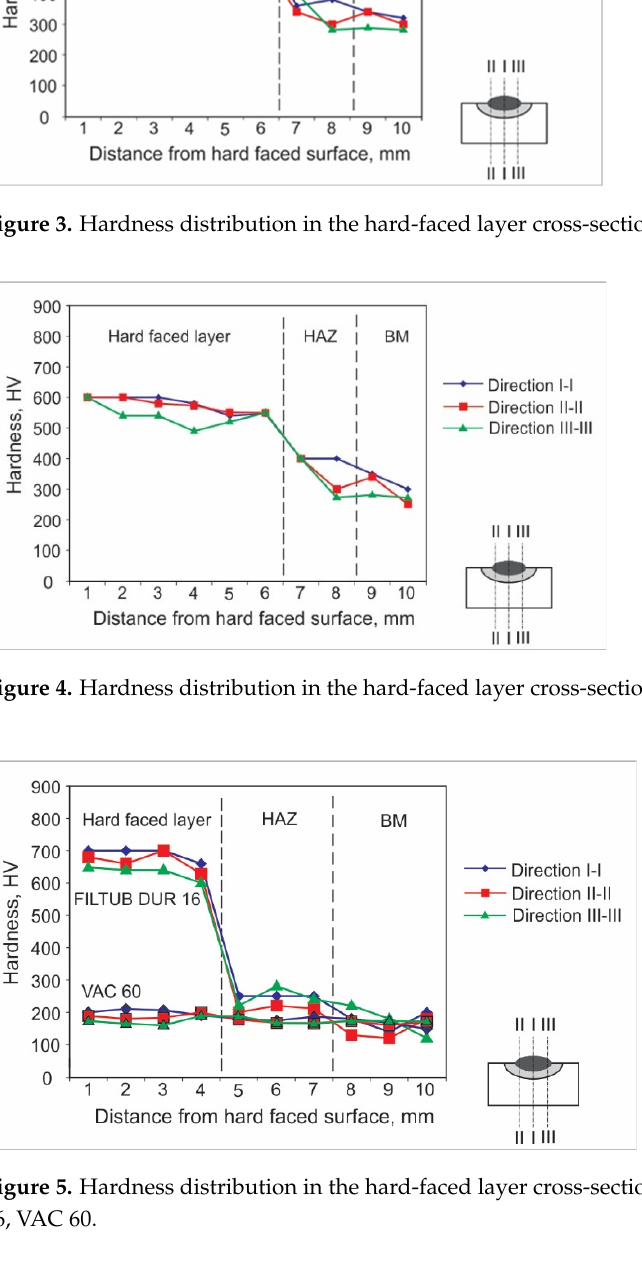
Figure 5. Hardness distribution in the hard-faced layer cross-section, BM-S235JR, FM-FILTUB DUR 16, VAC 60. Figure 6 shows the hardness measurement results obtained for hard-facing by the GMAW procedure with preheating at 110 °C, with cored wires FILTUB DUR 16 and VAC 60 of diameter d e = 1.2 mm on the sample, the base metal of which was steel S355J2G3. From the analysis of results presented in Figure 6, one can observe that for the case of GMAW hard-facing, the applied base metal has no influence on the output character- istics of the hard-faced layers; although there is a small difference only in the case of the BM hardness, everything else is quite similar.